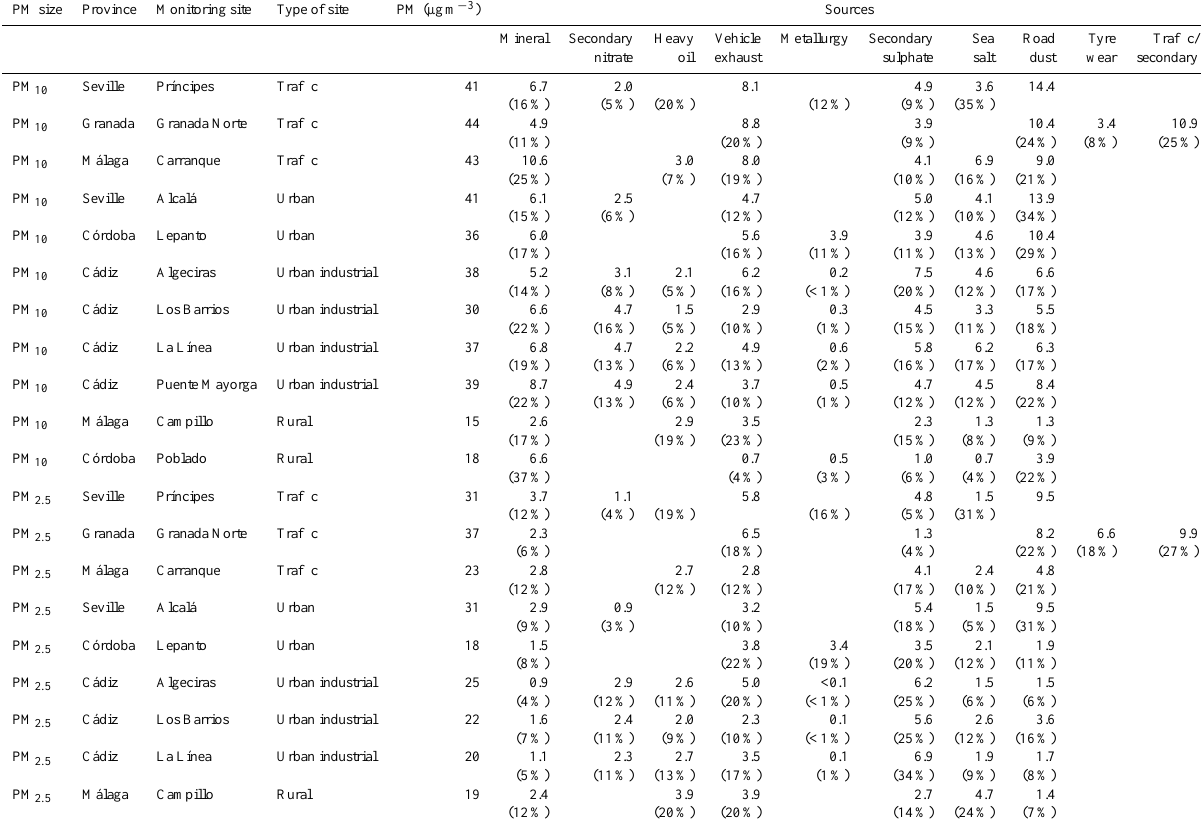
Table 3. Average absolute (µgm − 3 ) and relative (%) source contributions to PM 10 and PM 2 . 5 levels. PM size Province Monitoring site Type of site